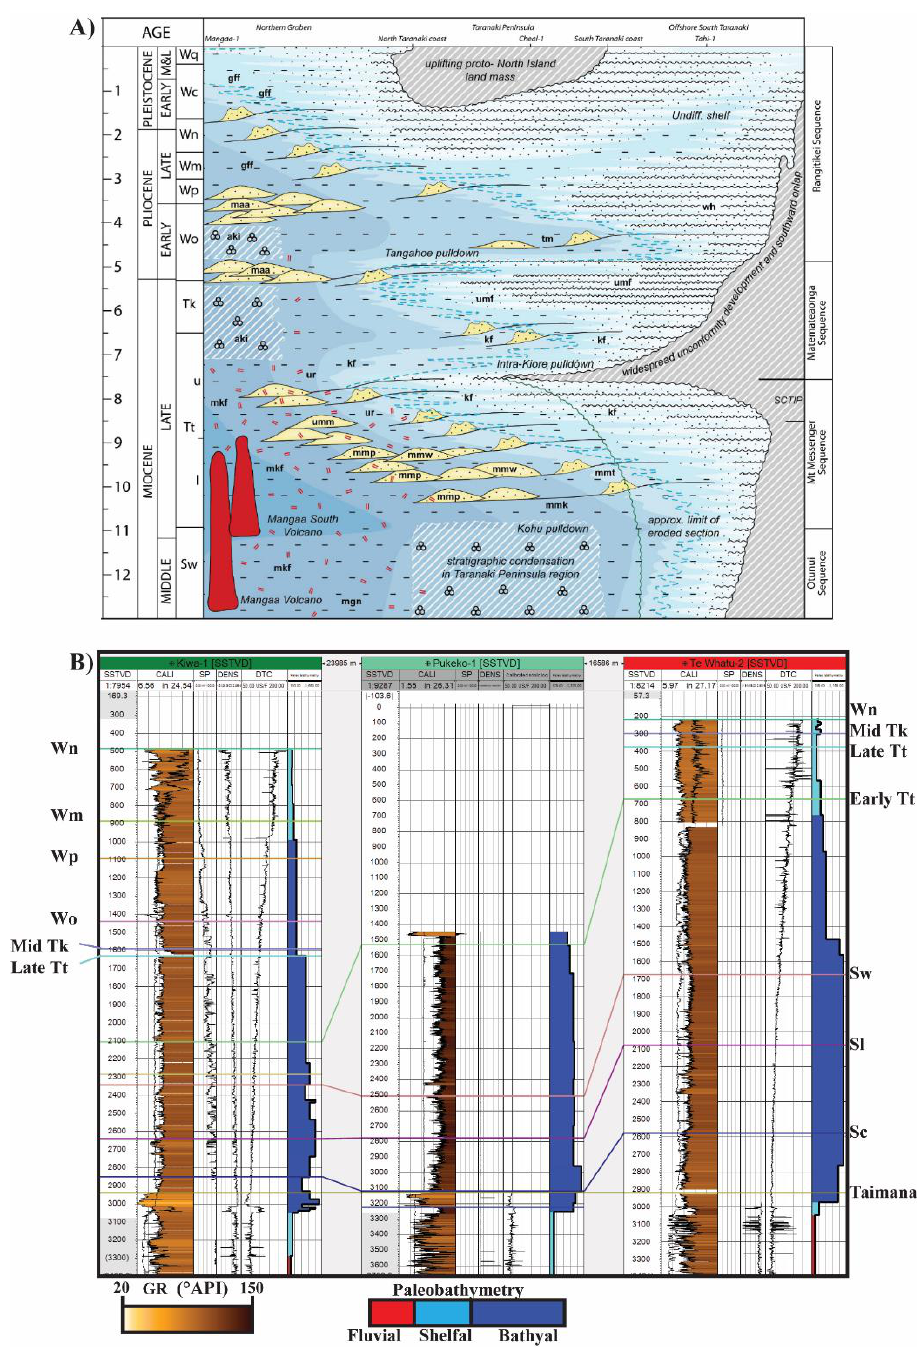
Figure 2. ( A ): Stratigraphic column of the southern Taranaki Basin modified after [15]. ( B ): Strati- graphic cross section flattened on the Taimana formation along depositional dip through the Te Whatu-2, Pukeko-1, and Kiwa-1